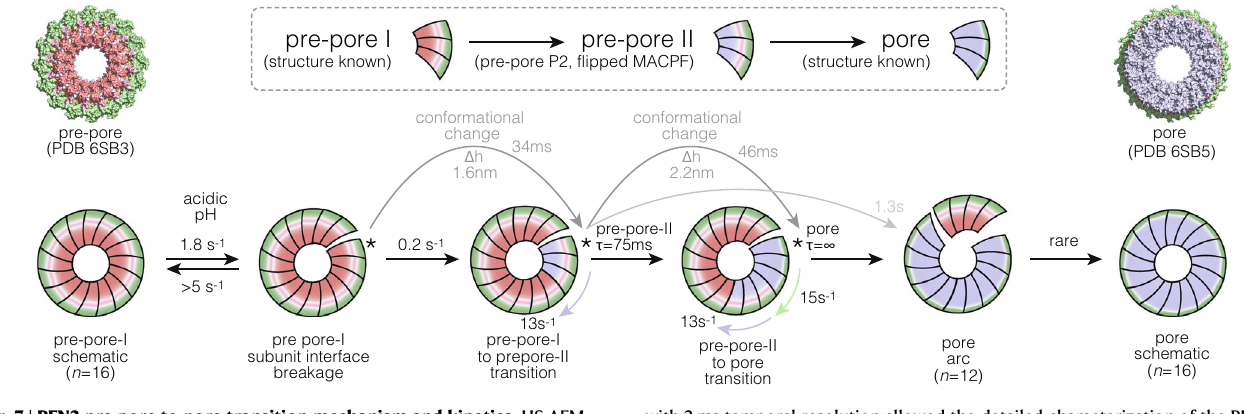
with 2ms temporal resolution allowed the detailed characterization of the PFN2 pre-pore to pore transition